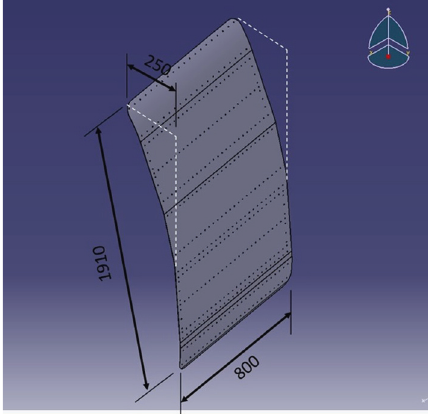
Figure 1: Outer skin aircraft